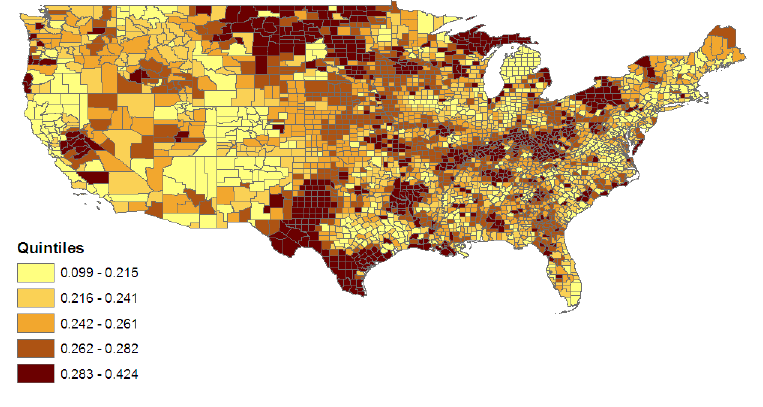
Figure 6 . Rate of obesity without diabetes, US counties, model 2.